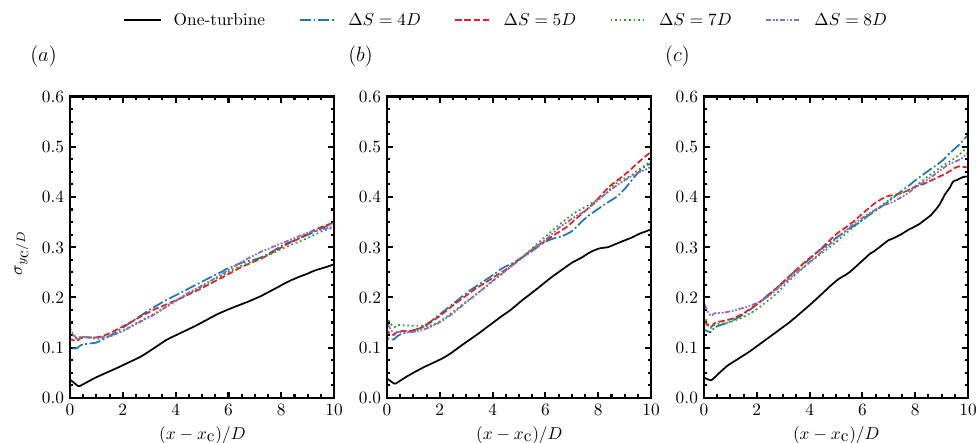
Figure 13. Streamwise variations of the standard deviations of the instantaneous spanwise wake centers under different inflow conditions for ( a ) inflow1, ( b ) inflow2 and ( c ) inflow3.